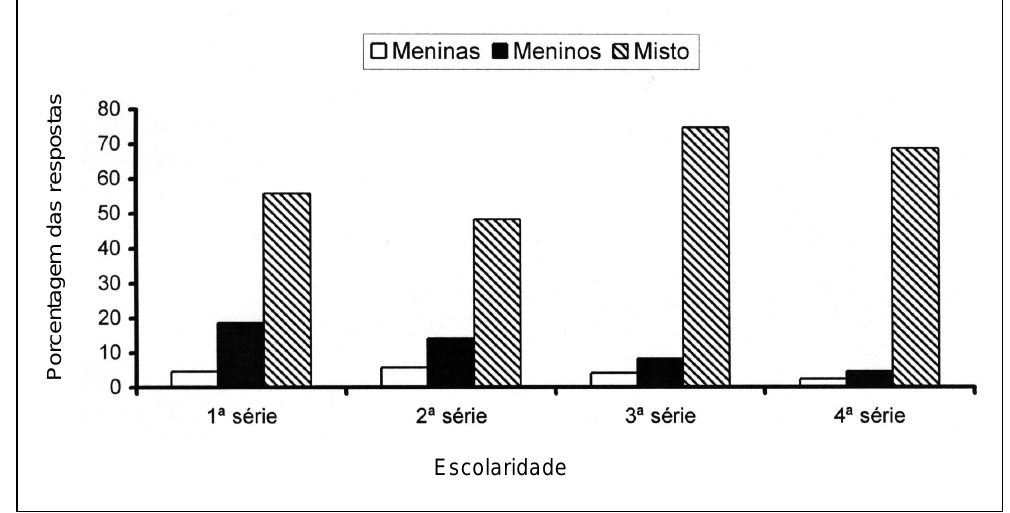
Figura 2 . Porcentagem das classificações pelos meninos, por séries, das brincadeiras exclusivas de meninos, de meninas ou mistas